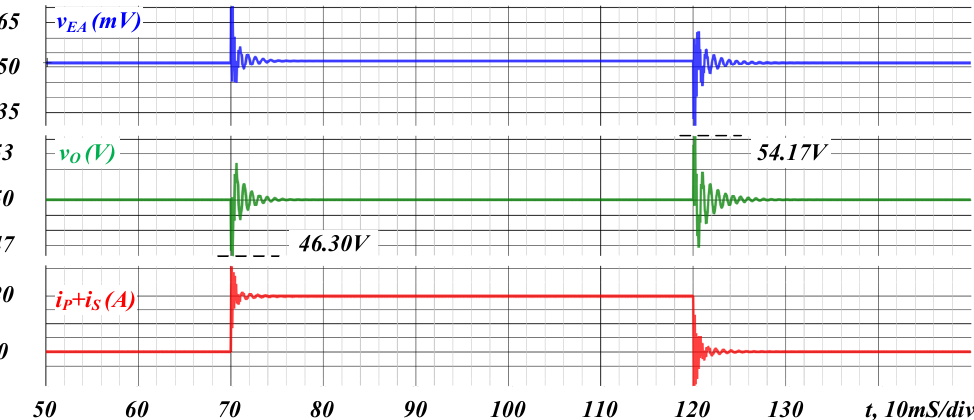
Energies 2021 , 14 , 64 FOR PEER REVIEW Figure 12. Simulation result of the transient response of the stacked buck converter with the complementary control method.